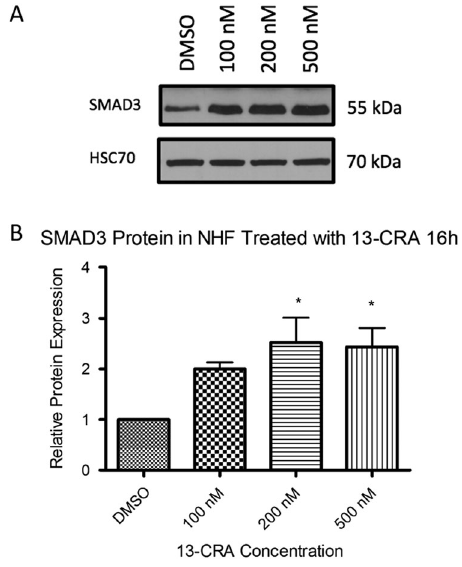
Fig. 3 a Sample western blot for SMAD3 protein in NHF treated with various concentrations of isotretinoin (13- cis -retinoic acid; 13-CRA) for 16 h. b Quanti fi ed SMAD3 protein expression. Error bars represent SEM. n = 4. Heat shock cognate protein 70 (HSC70) * p <